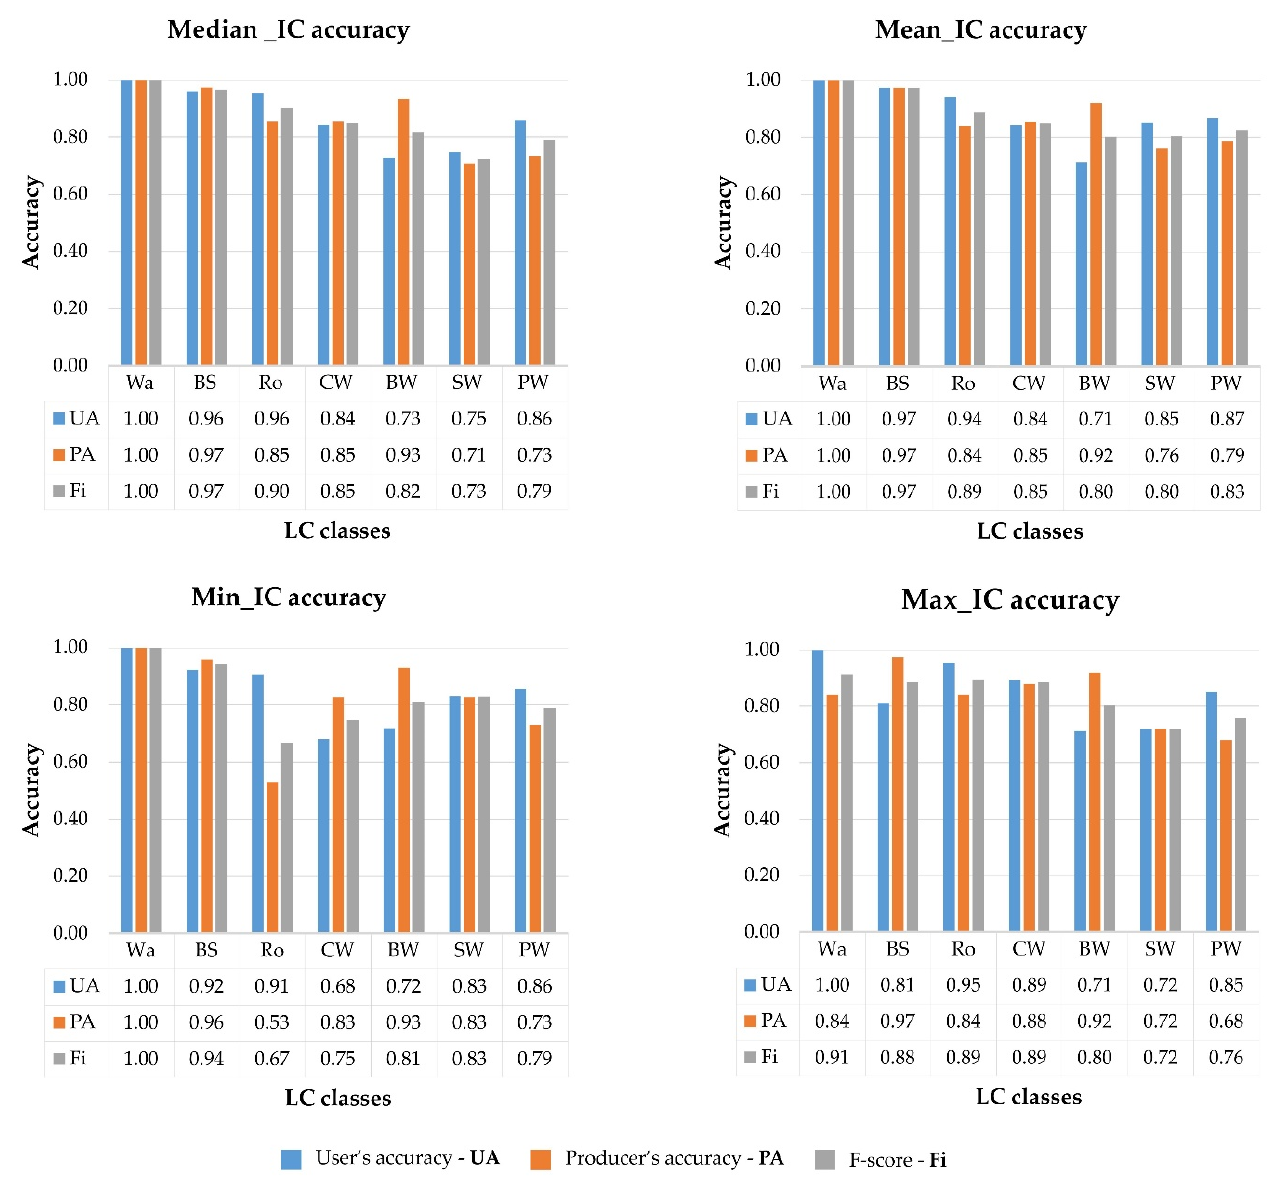
Figure A2. Accuracy values of the statistical operators adopted to reduce the images.